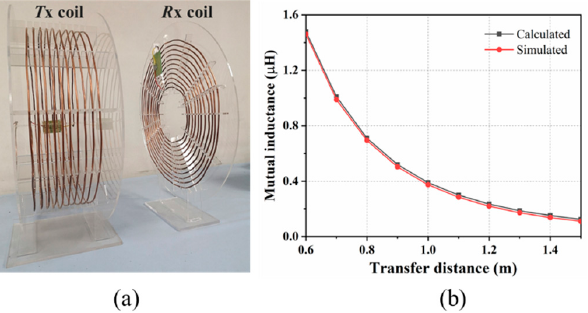
Figure 4. ( a ) The diagram of transmission coils. ( b ) Relationship between mutual inductance and d tr.